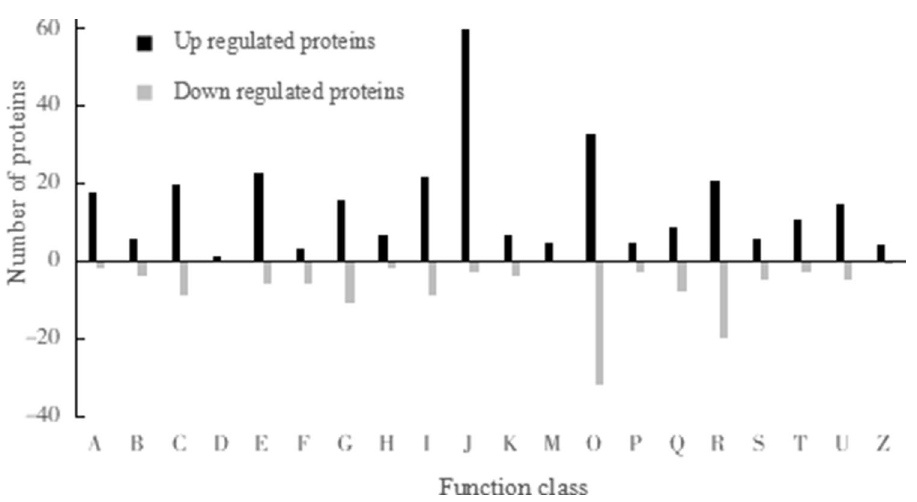
Figure 3. KOG annotation of differentially abundant proteins in high potassium